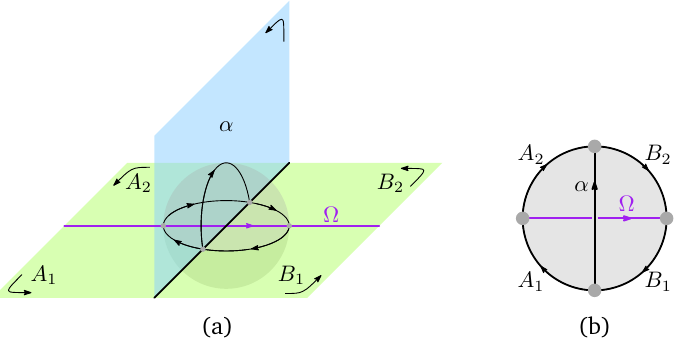
Figure 5: Application of the evaluation map to the intersection of the boundary Wil- son line Ω with an edge on the physical boundary (a) leads to a tetrahedral diagram (b) that in special cases evaluates to the MPO symmetry or MPO intertwiner tensors. Note that the lines labeled by Ω and α do not cross, as is evident from